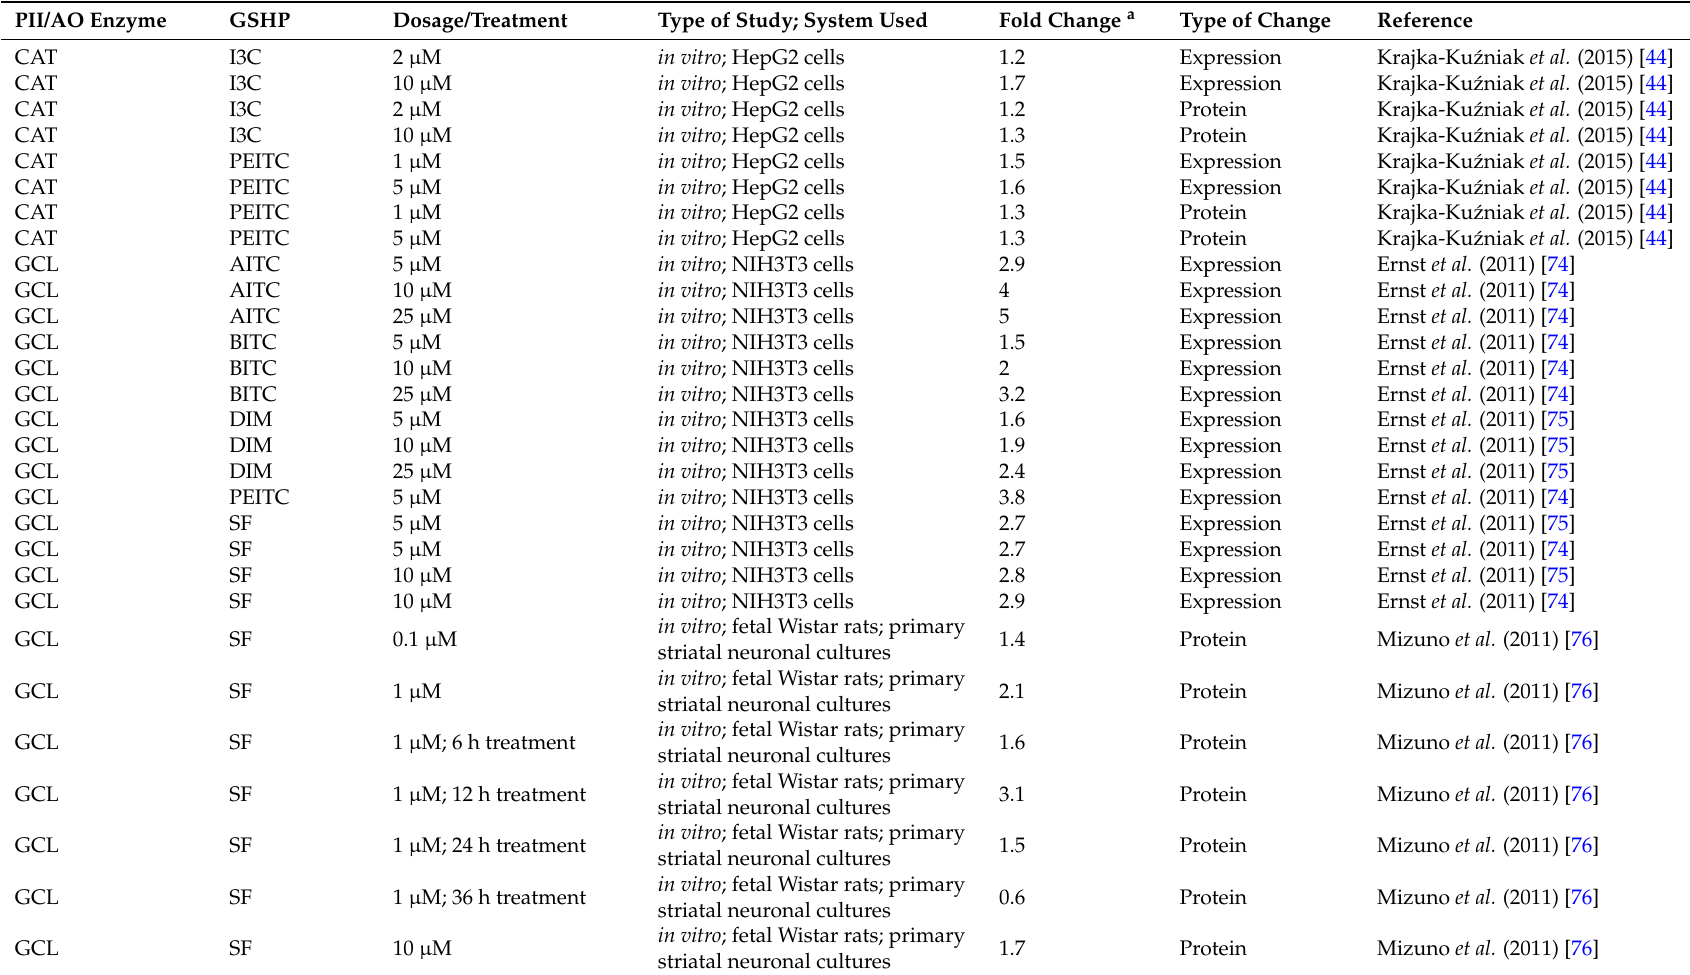
Table 1. Summary of human, animal, and in vitro studies of the effects of glucosinolate hydrolysis products on phase II and antioxidant enzymes; updated from [73]. PII/AO